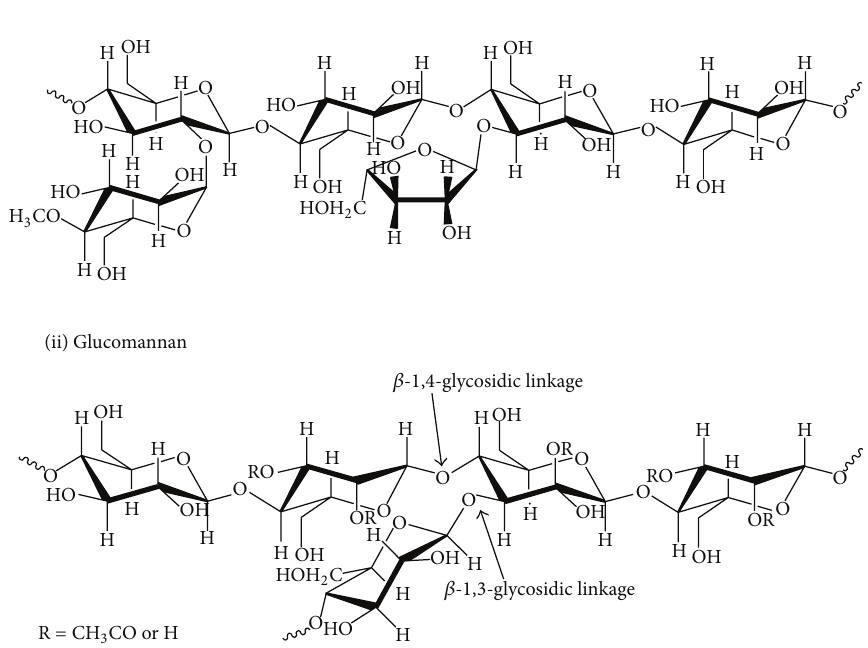
Figure 4: Chemical structure of hemicellulose compounds (xylan and glucomannan are the most existing